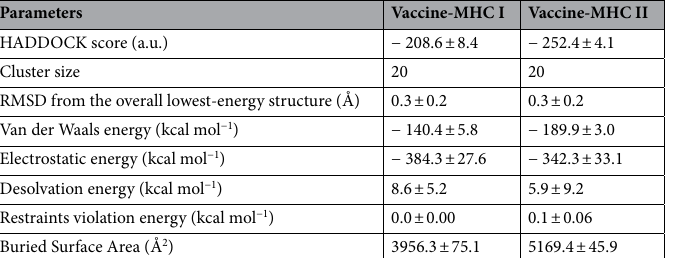
Table 8. Statistics of the best refined docked vaccine-MHC I and vaccine-MHC II complexes. Strong protein interaction expressed in arbitrary units (a.u.) is represented by smallest HADDOCK score.